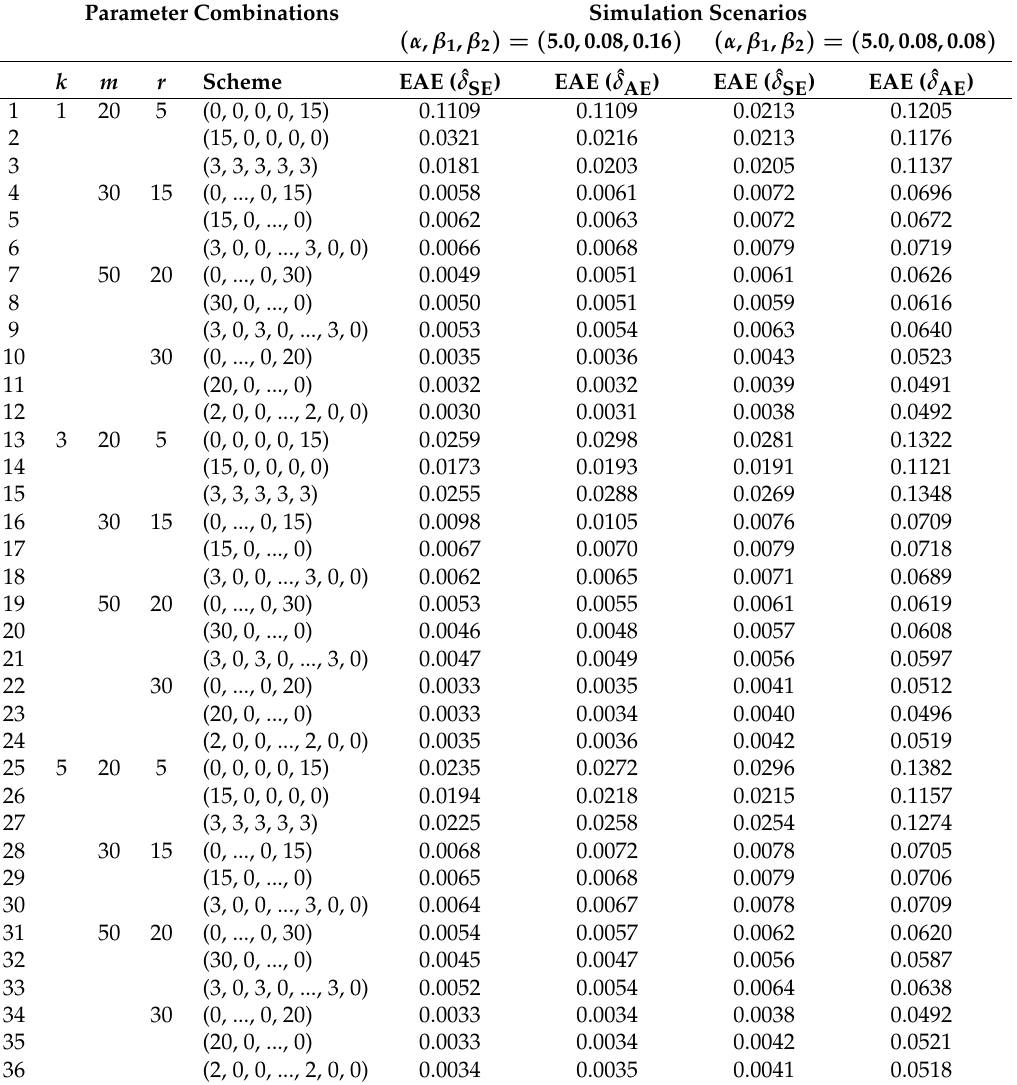
Table 2. The ESEs for ˆ δ SE and ˆ δ AE under two different Burr type XII distributions. Parameter Combinations Simulation